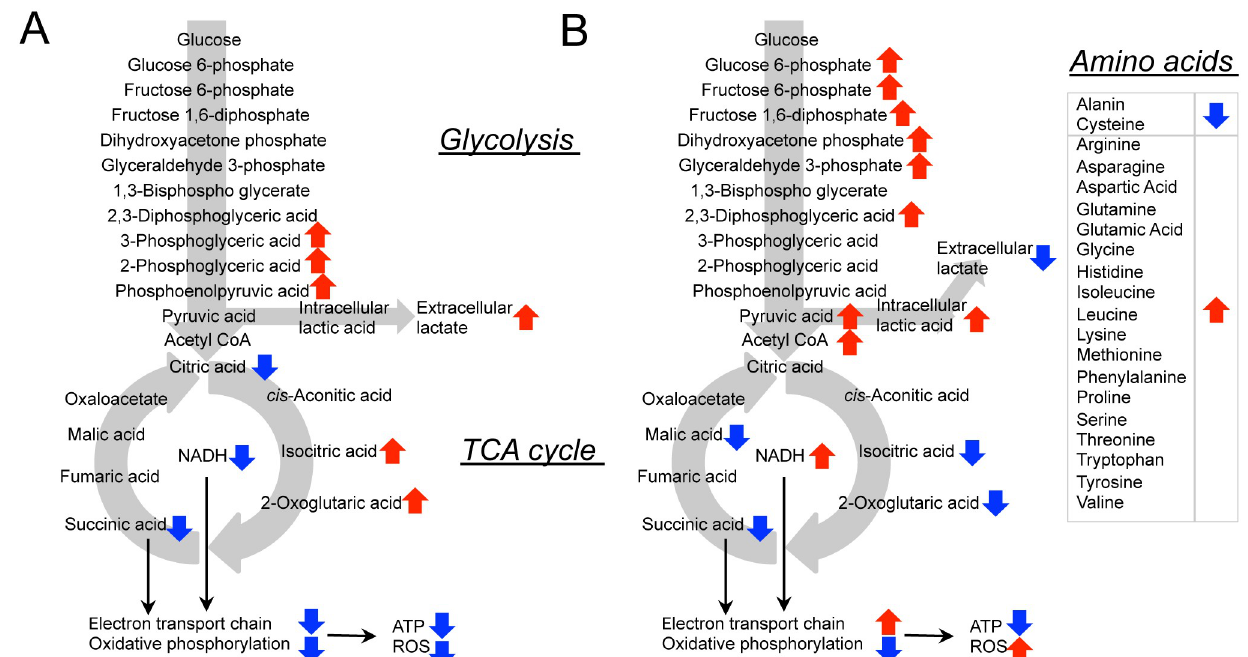
Fig 7. ONS-76, -F8 and DCA-treated cells exhibit different metabolic profiles. Schematicdiagram of the metabolicpathway. The red and blue arrows represent increasedand decreased metaboliteconcentrations in ONS-F8 compared with ONS-76 (A), and in DCA-treated cells comparedwith non-DCA-treated cells